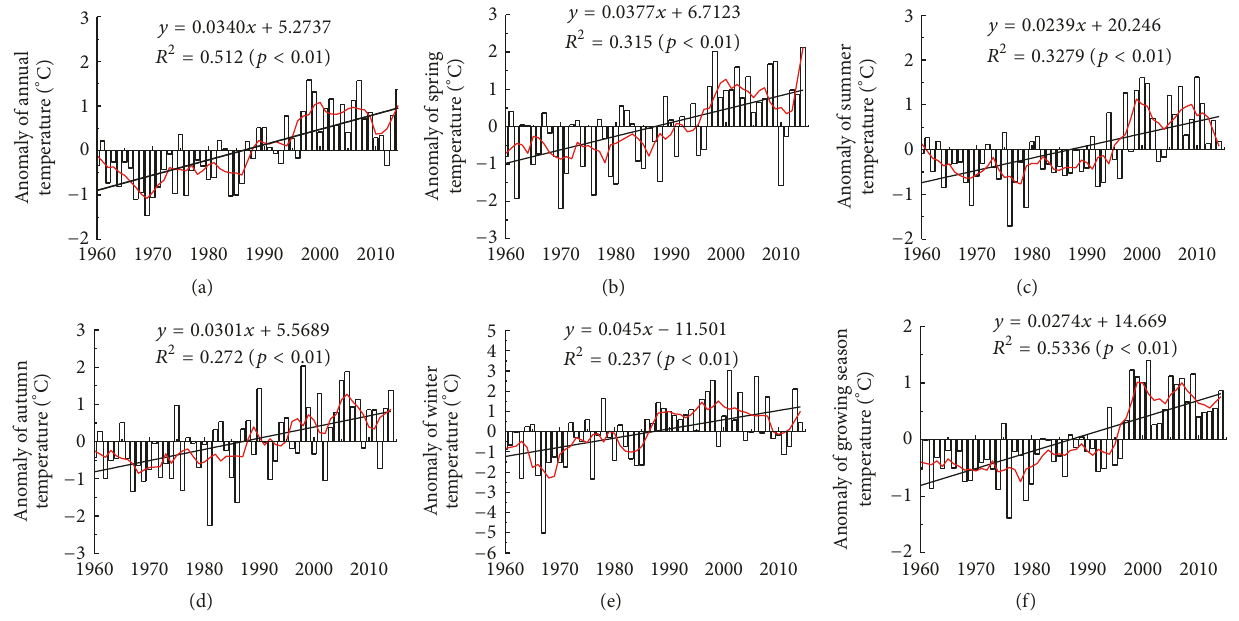
Figure 2: Anomaly of regional average temperature curves over the BTSSR, 1960–2014. The blackline represents the linear trends for (a) annual, (b) spring, (c) summer, (d) autumn, (e) winter, and (f) growing season. The redline represents the 5-year moving